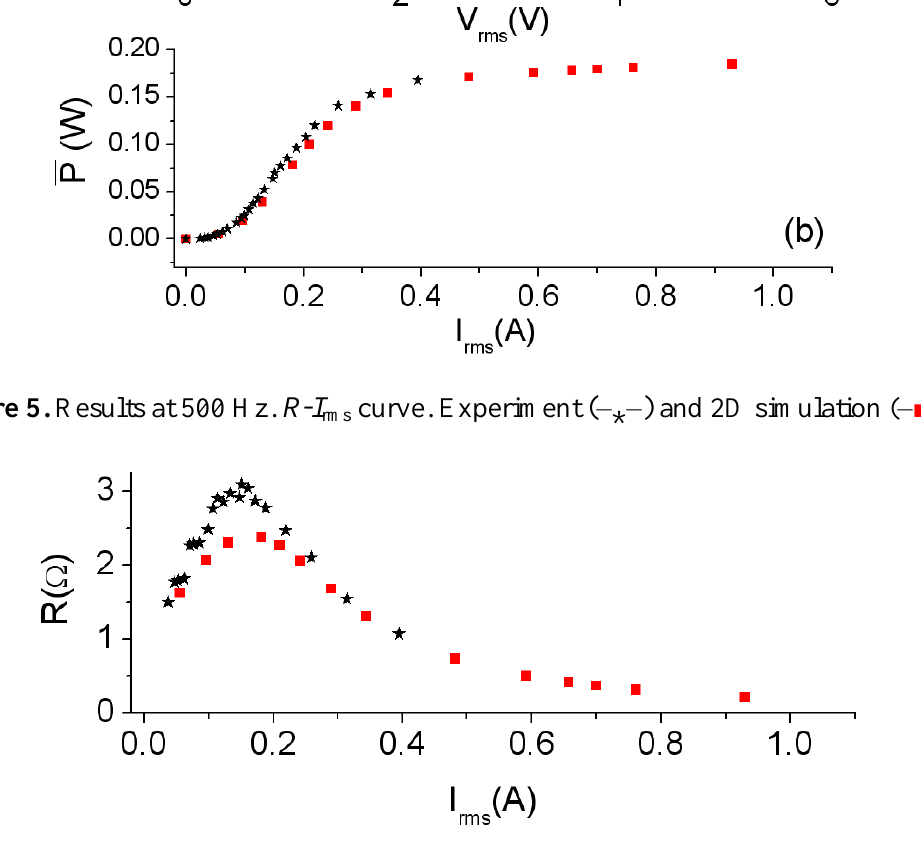
Figure 4. Results at 500 Hz. ( a ) P - V and 2D simulation (– ■ –).